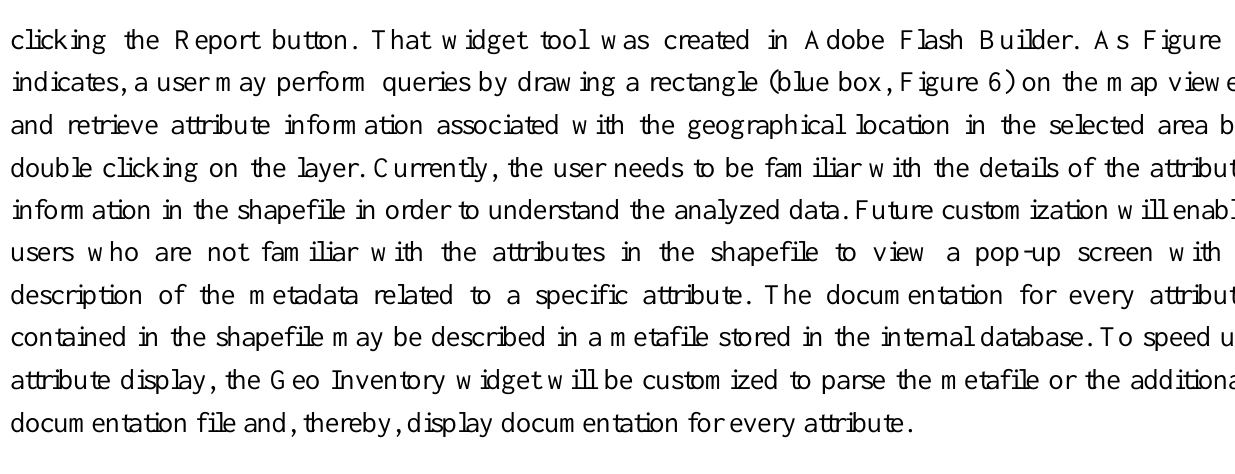
Figure 5. A query of sample